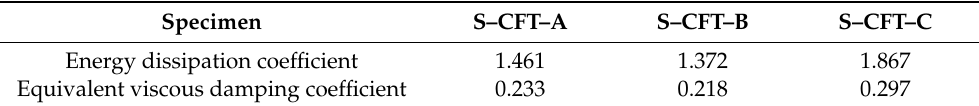
Figure 15. Energy dissipation coefficients of the specimens. Table 5. Energy dissipation indexes of the